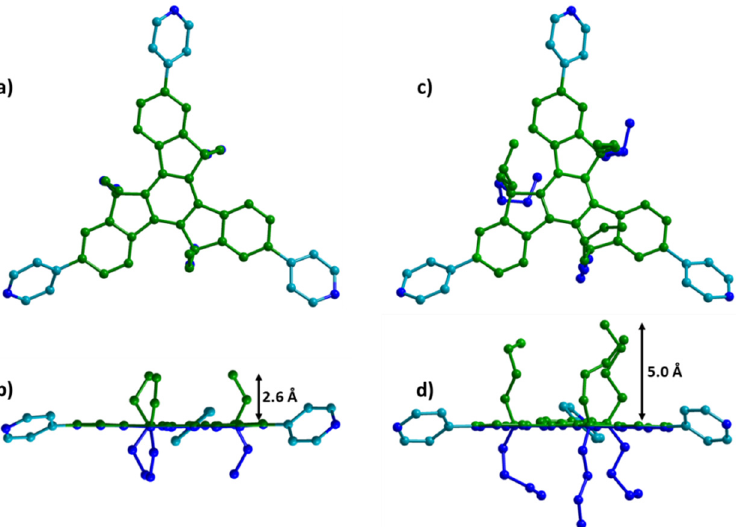
Figure 2. X-Ray crystal structures of LEt (left) and LBu (right): ( a , c ) top views (clockwise face in green); and ( b , d ) lateral views showing both rotating faces (clockwise in green, anticlockwise in blue).